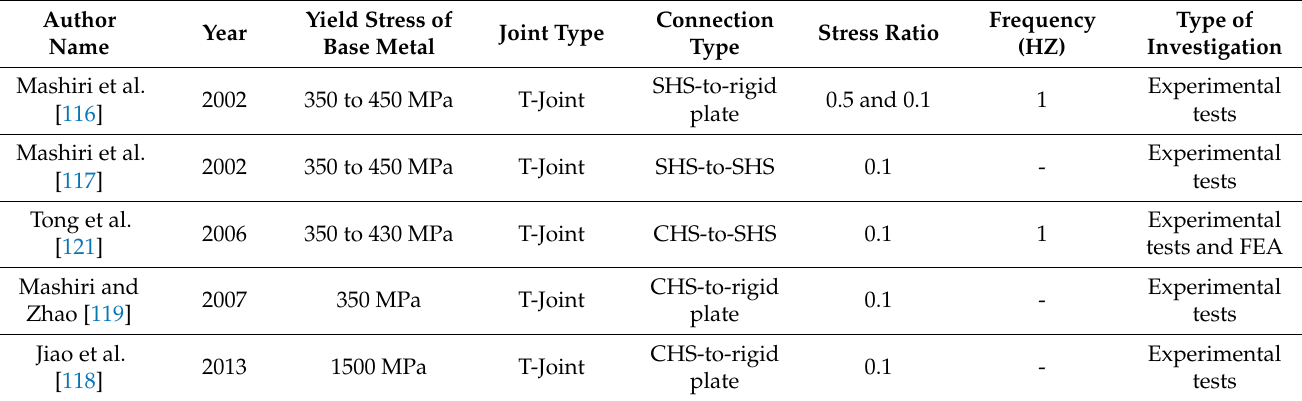
Table 5. Fatigue strength of fillet welded joints on hollow